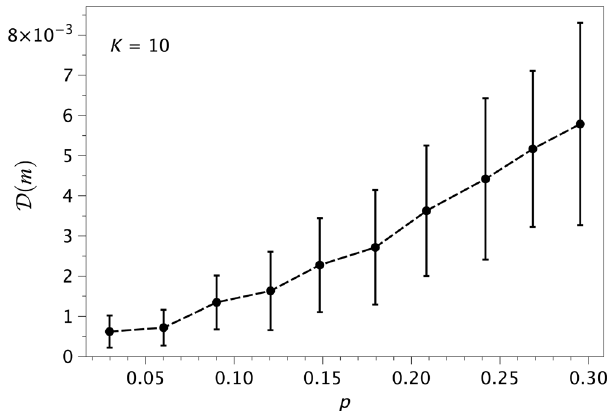
FIG. 17. Scenario 6b. Detectability measure D ð 3 Þ for a two- layer multiplex with K ¼ 10 nodes per layer, where each layer is a connected Erdos-Renyi graph (link probability 0.65). The second layer is a replica of the first layer, where a percentage p of nodes have been rewired. Results have been averaged over 10 2 network realizations for each